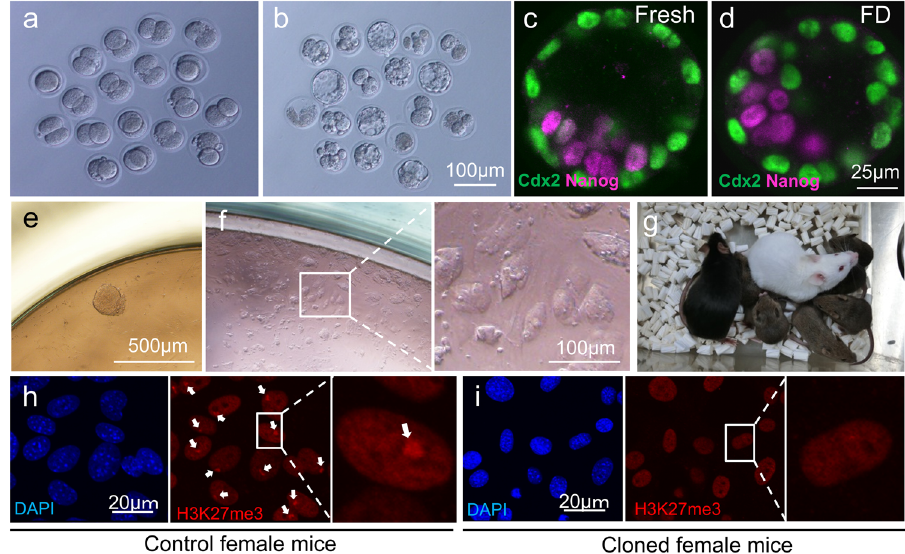
Fig. 5 Establishment of ntES cell lines and production of cloned mice from FD somatic cells. a , b Preimplantation development of cloned embryos at two- cell embryos and blastocysts derived from FD somatic cells. Those developed embryos were used for ntES cell establishment (see Table 1 for more details). c , d Immunostaining of cloned blastocysts derived from fresh ( c ) and FD somatic cells ( d ). The trophectoderm (CDX2-positve) show green. Inner cell mass (Nanog-positive) show red. n = 3 biologically independent experiment. See Supplementary Table 6 for more details. e , f Establishment of ntES cell lines from cloned blastocysts. Outgrowth observed 10 days after seeding in a 96-well plate ( e ). Three days after the fi rst passage of this outgrowth ( f ). See Table 1 for more details. g The fi rst cloned mouse “ Dorami ” derived from FD Cumulus cell nucleus. Dorami delivered the next generation by natural mating. h , i Immunostaining of tail-tip fi broblast of control ( h ) and cloned ( i ) female mice using anti-H3K27me3 antibodies. The nuclei of fi broblasts were detected using DAPI staining (blue). H3K27me3-positive spot (inactive X chromosome) is red (high magni fi cation) and indicated by the arrow. Four cloned female mice and two control female mice were examined. See Supplementary Fig.